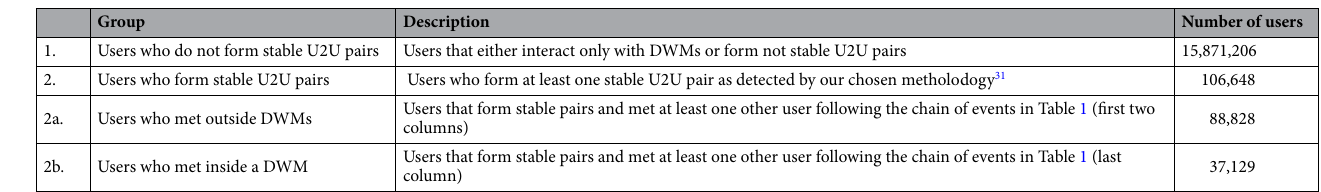
Table 2. Nomenclature. Definitions of all groups the users are divided to based on their behaviour. Number of users in each group is given in the last